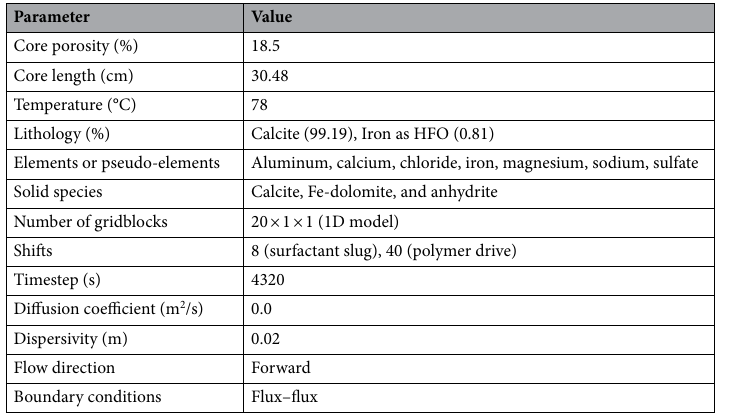
Table 3. Reservoir rock properties used for simulation (Tagavifar et al . 18 ).